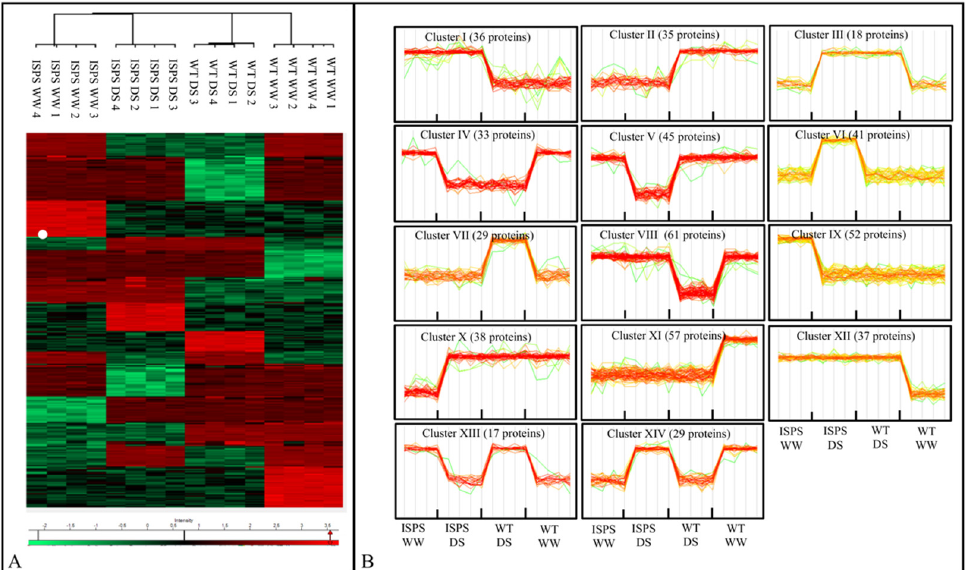
Figure 2. Heat map ( A ) and hierarchical clustering ( B ) of differentially abundant proteins (DAPs) according to one-way ANOVA analysis of wild-type (WT) and isoprene-emitting (ISPS) plants under well-watered (WW) and water stressed (WS) conditions. Heat map colours are based on the combined Z-scored (log 2 ) LFQ values. Green and red shades correspond to proteins that accumulated less and more, respectively.